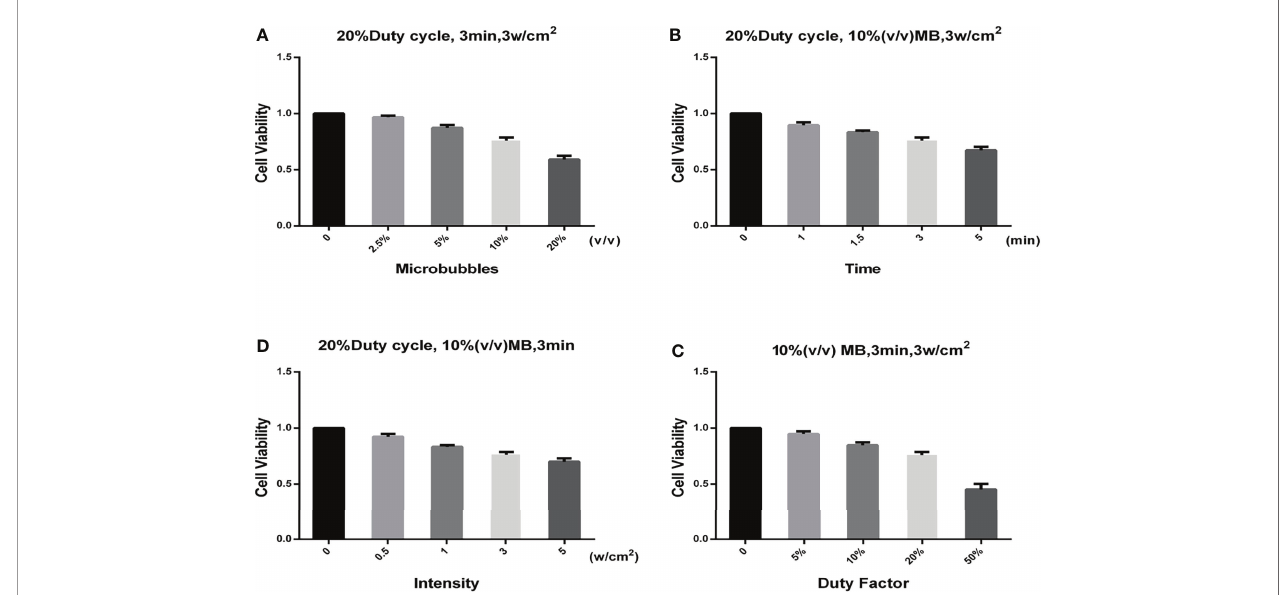
FIGURE 3 | Relationship between different parameters and the cell viability. (A) Relationship between the SonoVue ® microbubble concentration and the cell viability. The frequency, duty factor, treatment time, and ultrasonic intensity were 1 MHz, 20%, 3 min, and 3 W/cm 2 , respectively. (B) Relationship between the treatment time and the cell viability. The frequency, duty factor, SonoVue ® microbubble concentration, and ultrasonic intensity were 1 MHz, 20%, 10% (v/v), and 3 W/cm 2 , respectively. (C) Relationship between the ultrasonic intensity and the cell viability. The frequency, duty factor, SonoVue ® microbubble concentration, and treatment time were 1 MHz, 20%, 10% (v/v), and 3 min, respectively. (D) Relationship between the duty factor and the cell viability. The frequency, SonoVue ® microbubble concentration, treatment time, and ultrasonic intensity were 1 MHz, 10% (v/v), 3 min, and 3 W/cm 2 ,